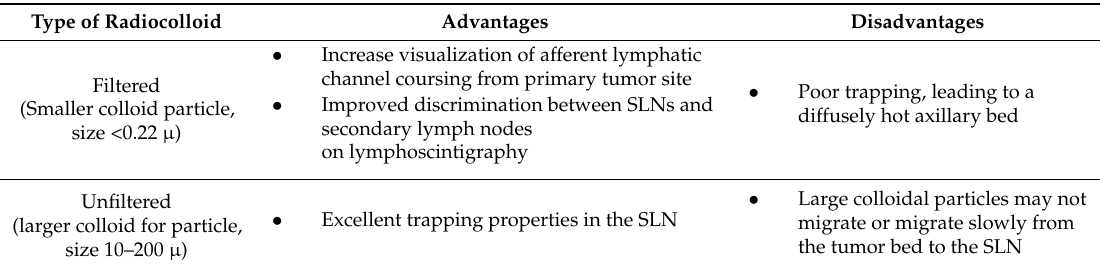
Table 2. Comparison of Filtered and Unfiltered Sulfur